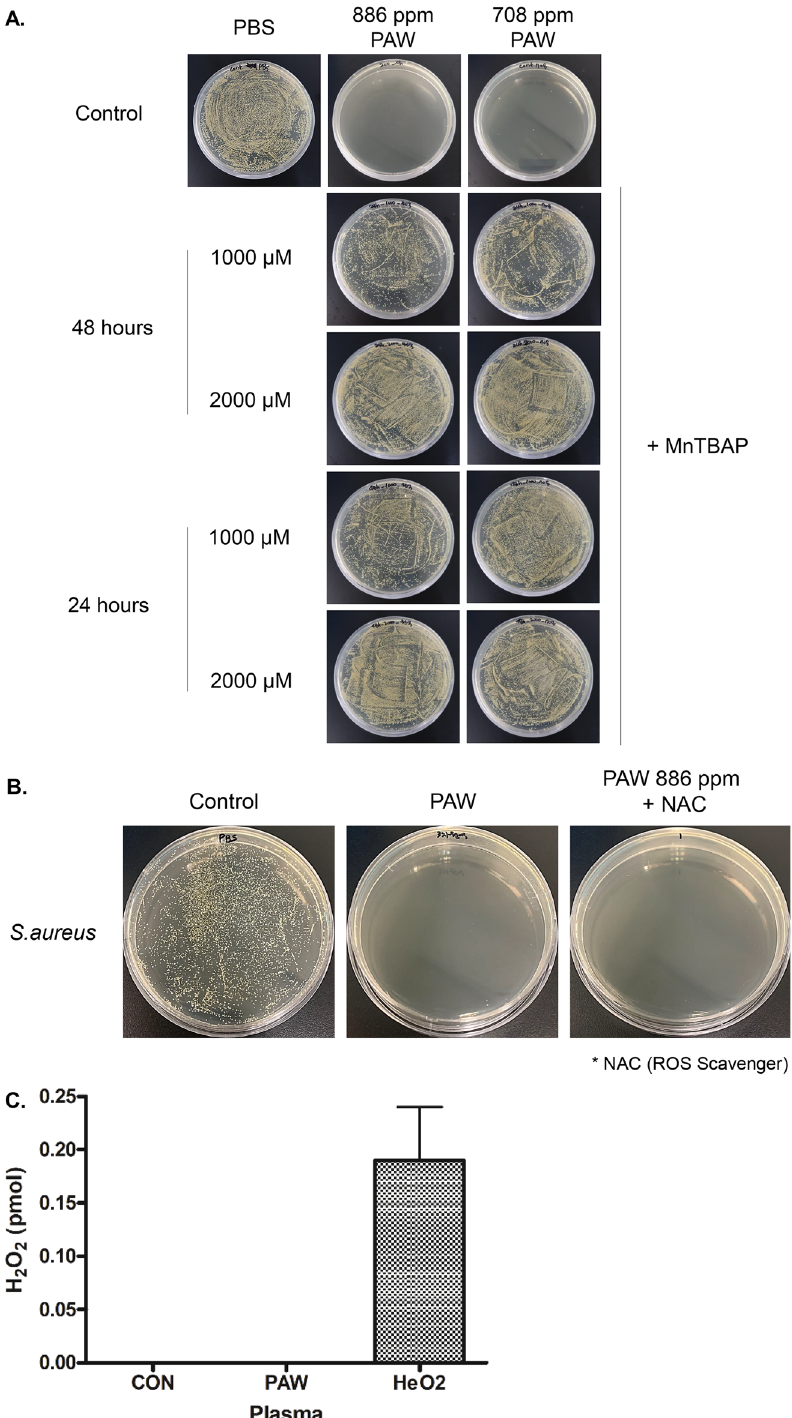
Figure 4. Peroxynitrate (ONOO − ) and reactive oxygen species (ROS) scavengers experiment demonstrated bactericidal activity of ONOO − in plasma-activated water (PAW). ( A ) Mn(III)tetrakis (4-benzoic acid) porphyrin (MnTBAP) as an ONOO − scavenger added to PAW solutions with 886 and 708 ppm nitrate had little antibacterial activity, regardless of MnTBAP treatment time (24 and 48 h) and concentration (1000 and 2000 μM). ( B ) Bactericidal effect of N -acetyl-l-cysteine (NAC) as a ROS scavenger-supplemented PAW solution with 886 ppm nitrate against Staphylococcus aureus was the same as that of PAW. ( C ) Quantitative comparison of effects of H 2 O 2 as ROS in PAW and HeO 2 gas-type plasma with DW as a control. There was no detectable H 2 O 2 in PAW or